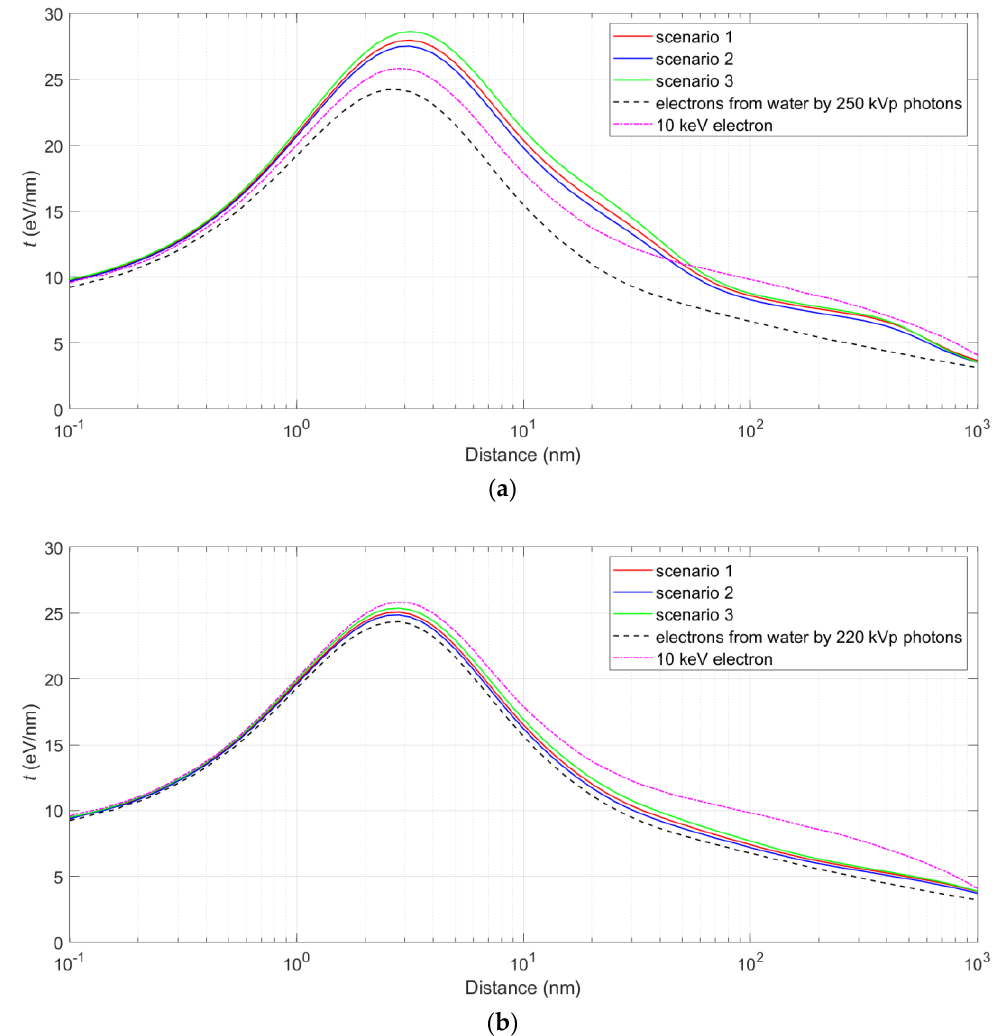
Figure 4. Energy weighted proximity functions of the secondary electrons produced from water at 1 mm depth, and the proximity functions of the electrons in the nucleus due to AGuIXs ( a ) and AuNPs ( b ) for the three scenarios.